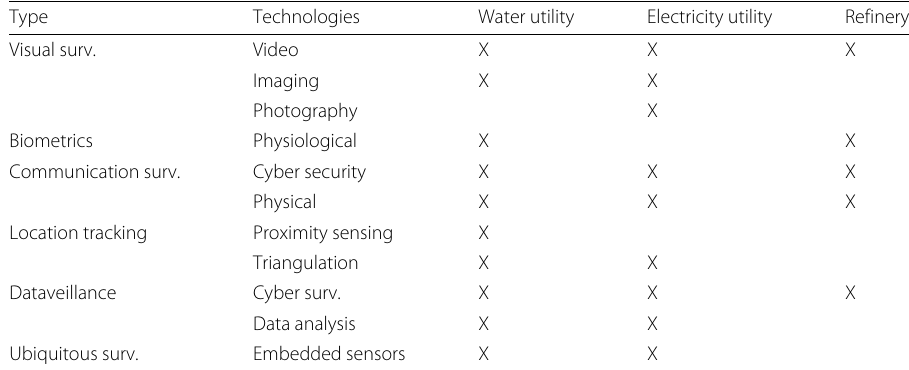
Table 3 Surveillance and security technologies per examined critical infrastructure Type Technologies Water utility Electricity utility Refinery Visual surv. Video X X X Imaging X X Photography X Biometrics Physiological X X Communication surv. Cyber security X X X Physical X X X Location tracking Proximity sensing X Triangulation X X Dataveillance Cyber surv. X X X Data analysis X X Ubiquitous surv. Embedded sensors X X